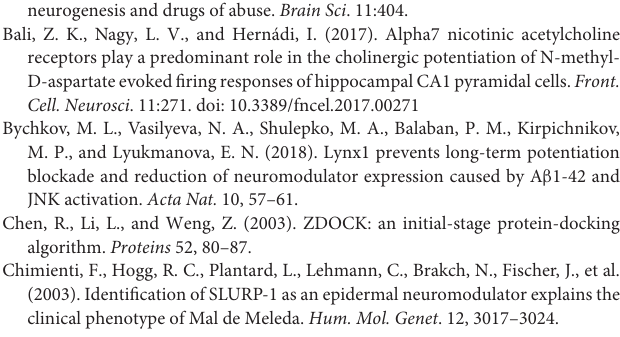
Supplementary Figure 1 | Amino acid sequence alignment of Ly-6/uPAR proteins of different origin. The signal peptides are removed. Invariant Cys residues are shown in yellow. Cys residues forming additional disulfide bonds in loop regions are shown in green. Disulfide bonds are shown by brackets. Predicted sites for attachment of a GPI-anchor and glycosylation are shown by cyan and magenta, respectively. Several possible GPI-anchor sites were predicted for human Lypd6b. Fragments of the Lypd6 and Lypd6b proteins used in this work are highlighted by orange background. The N - and C -terminal boundaries of the LU-domain are shown by vertical dashed lines. ∗ The proteins for which the presence of both the GPI-anchored and soluble form is reported. The loop regions are highlighted with a gray background. Supplementary Figure 2 | Customized MD/ensemble protein–protein docking protocol and a two-step post-scoring procedure to select the most probable α 7-ECD/ws-Lypd6 complex. Supplementary Figure 3 | Conformational plasticity of ws-Lypd6. Comparison of root-mean-square fluctuation (RMSF) in MD trajectories of ws-Lypd6 with NMR generalized order parameters (S 2 , mean ± SD), which characterize the amplitude of the backbone motions at the ps-ns timescale. RMSF values are shown for six 200 ns trajectories [three trajectories for ws-Lypd6 and three trajectories for ws-Lypd6 with removed C -tail (Leu83-Ala95)]. Threshold value (S 2 < 0.8) distinguishes residues with high-amplitude motions at ps-ns timescale. The regions of the loops and C -tail are highlighted by a gray background. Two short loops in the “head” region are denoted as “head-1” and “head-2.” The S 2 values are taken from Paramonov et al.